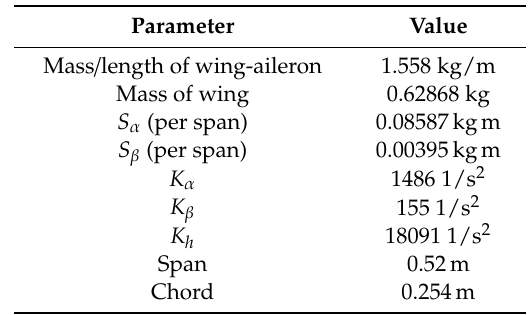
Table 3. Mass, Inertial, Sti ff ness, and Geometrical parameters.